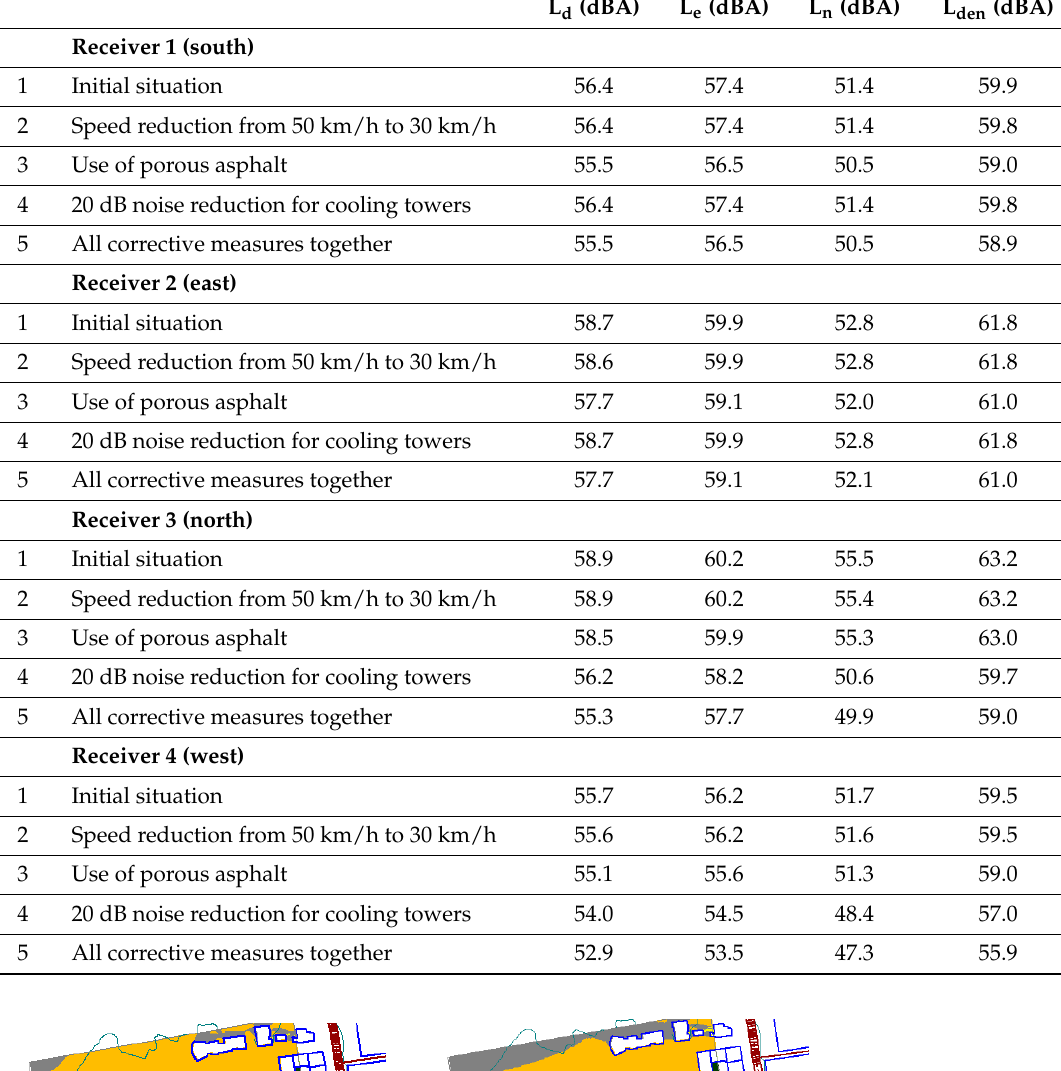
Table 6. Noise level received in each of the facades of the hospital according to our model after applying different corrective measures.